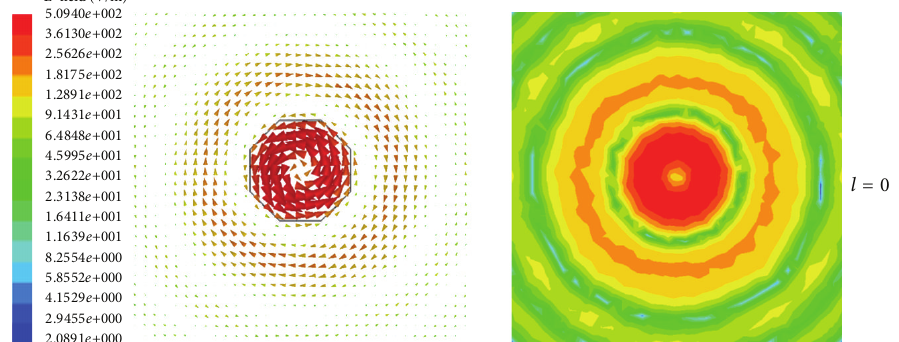
Figure 5: The vector and magnitude of electric field with 𝑙 = 0 at